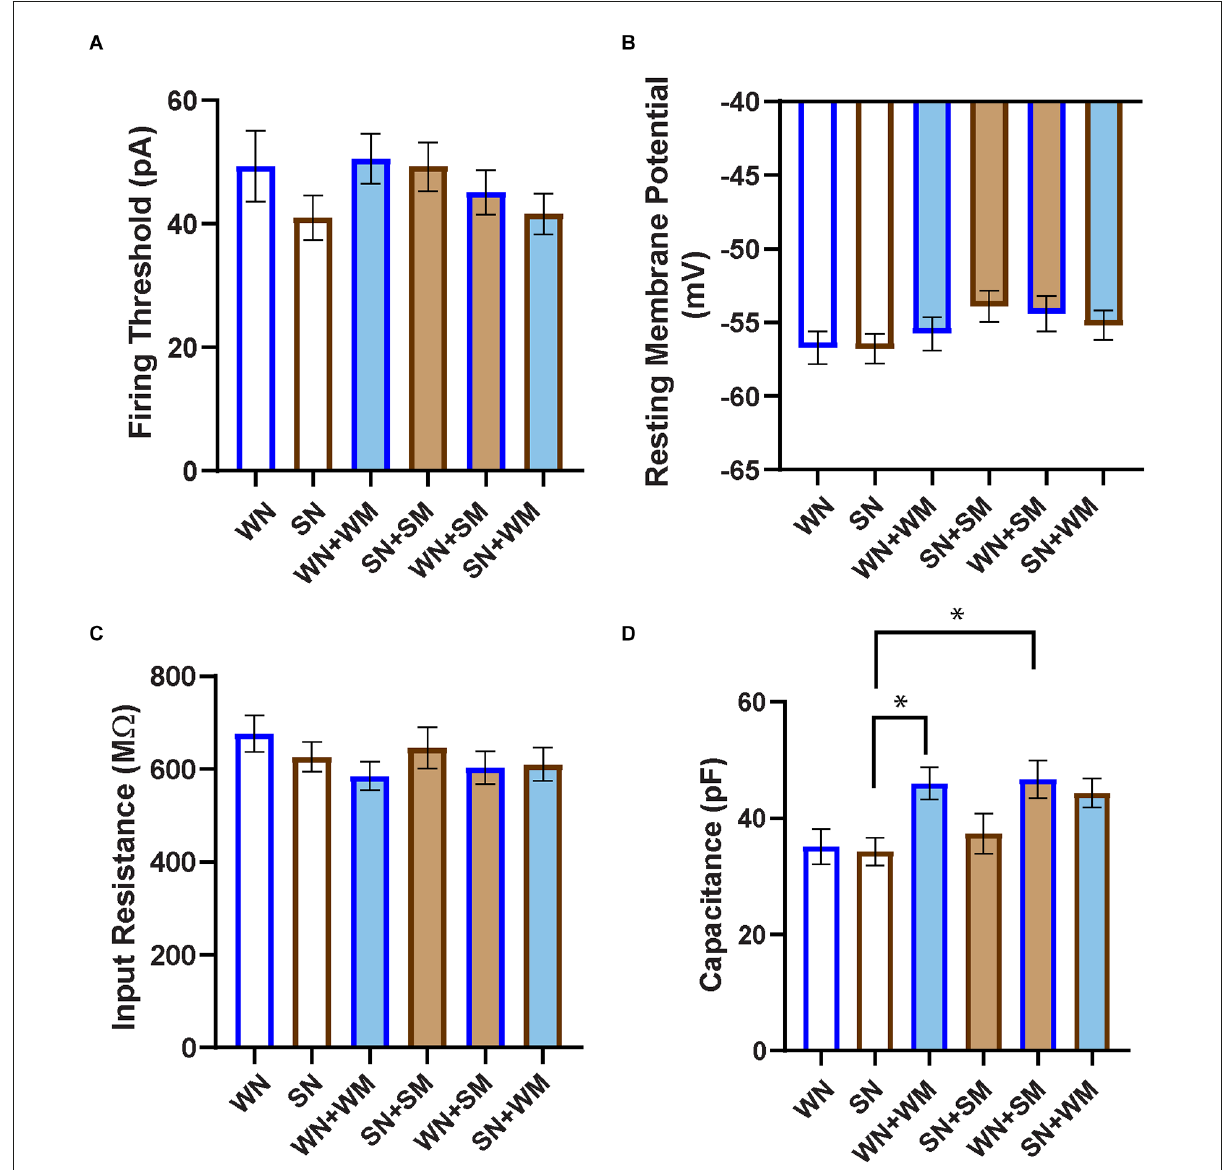
FIGURE5 Passive properties of WKY and SHR neurons co-cultured with and without cardiomyocytes. (A) The firing threshold was determined in current- clamp mode, and was defined as the smallest current step pulse that evoked at least one action potential for the neuron recordings shown in Figure4 . (B) Restingmembranepotentialwasdeterminedimmediatelyafterestablishingwhole-cellrecording. (C) Inputresistancewascalculated from the responses obtained at the stable end of applied stimuli, without the presence of nearby APs. No significant difference in firing threshold, resting membrane potential, or input resistance was observed between any co-cultured groups. (D) Capacitance was taken as the readout value from the pClamp amplifier after capacitance compensation in the established whole-cell mode. SHR neurons (SN) showed smaller capacitance than WKY N co-cultures with cardiomyocytes from either strain (WN + WM, WN + SM). WN, n = 30 neurons from N = 17 primary culture preparations; SN, n = 27, N = 14; WN + WM, n = 24, N = 18; SN + SM, n = 30, N = 15; WN + SM, n = 26, N = 15; SN + WM, n = 28, N = 9; non-parametric Kruskal-Wallis test with Dunn’s multiple comparison test, ∗ p < 0.05, error bars represent s.e.m.